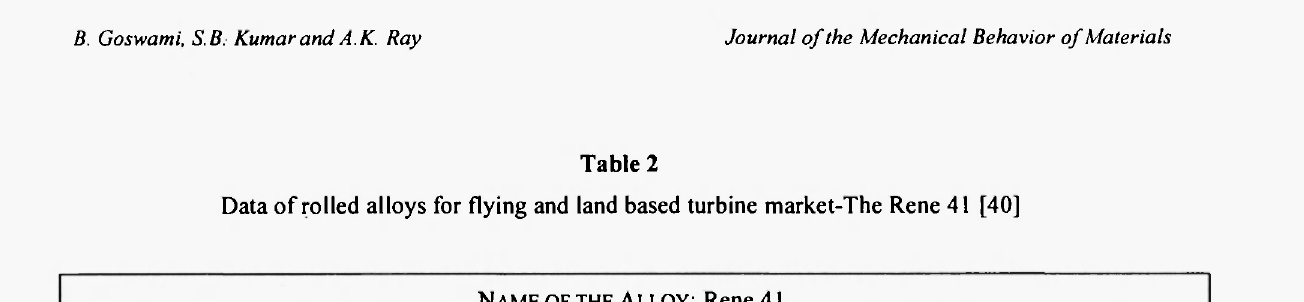
NAME OF THE ALLOY : Rene